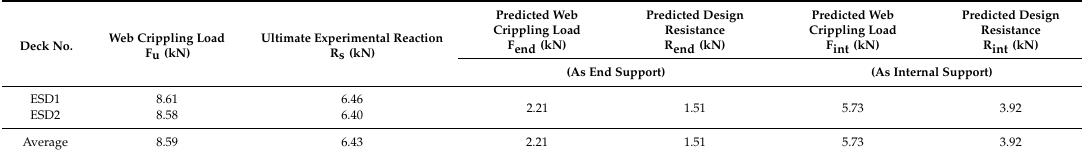
Table 6. Experimental and calculated results for the end support tests (experiment group (d)).